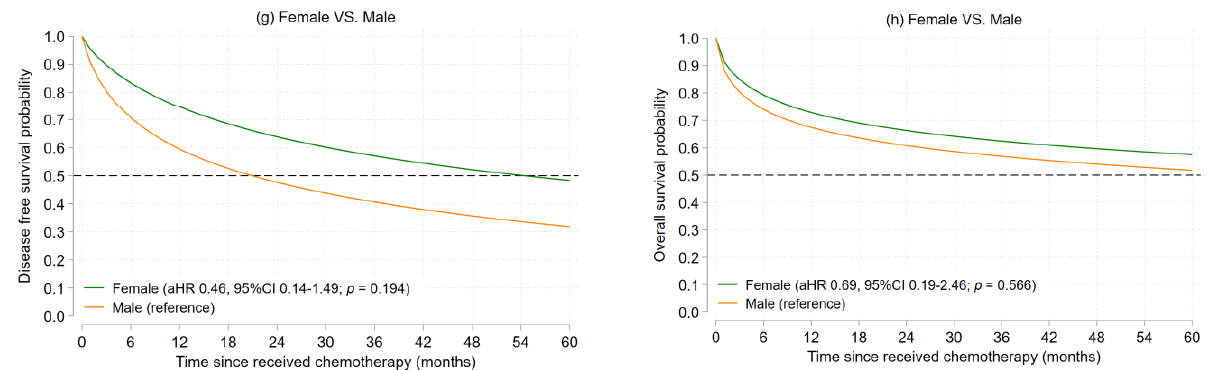
Figure 2. The estimated 5-year DFS and 5-year OS of Ewing’s sarcoma patients by the Flexible parametric survival model ( a – h ).